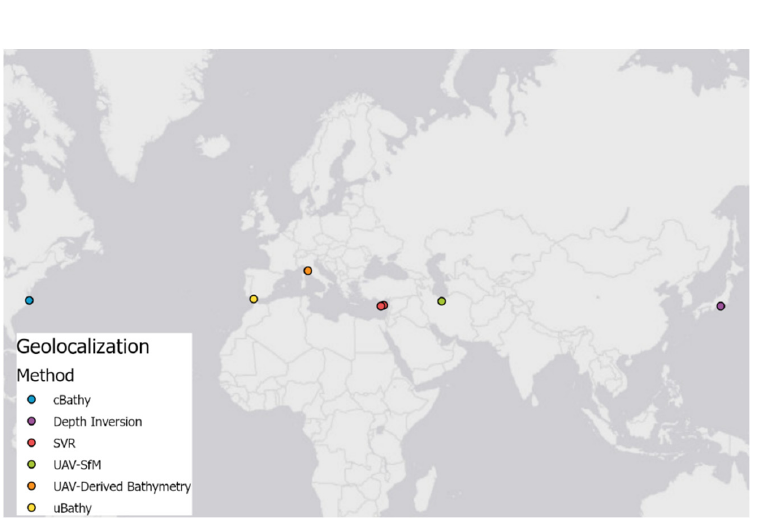
Figure 2. Map presenting the location of each measurement site according to the method used to determine the waterbody depth.